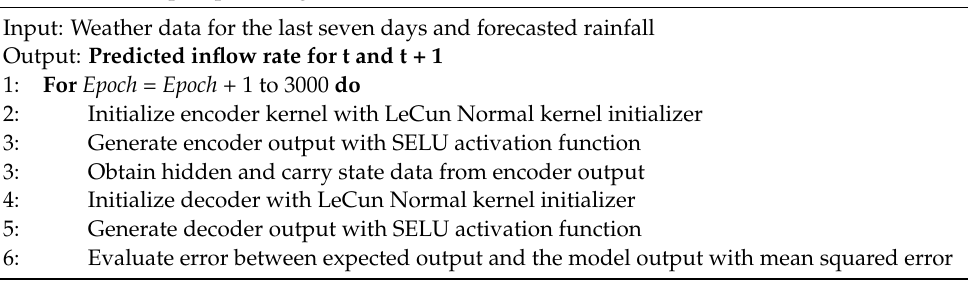
Algorithm 1: Seq2Seq Training Procedure.